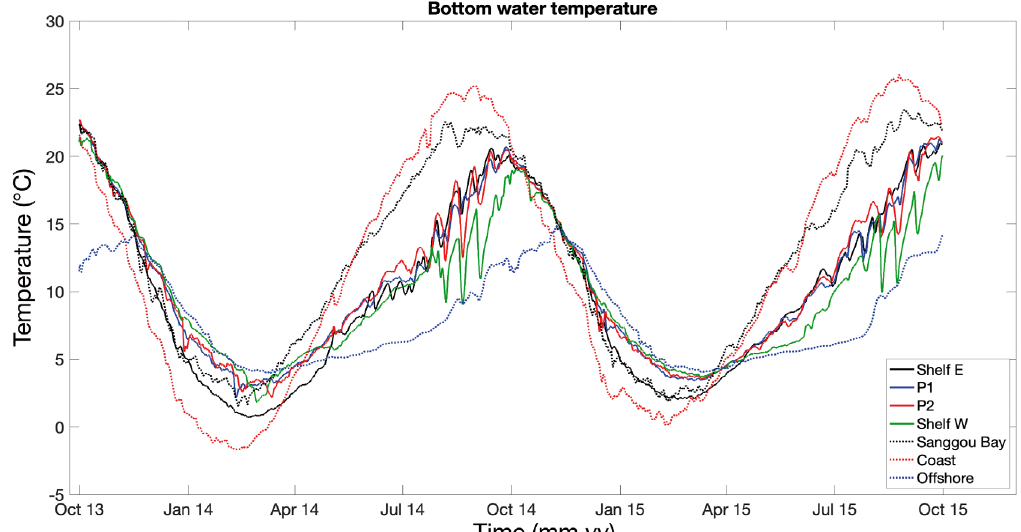
Fig. 4. Time series of bottom water temperature from locations at the northern shelf of the Yellow Sea and at Sanggou Bay. The positions are marked on the map in Fig. 1, and the line colors are similar to the colors of the dots. Black dotted line: Sanggou Bay location; red dotted line: location near the coast; blue dotted line: location offshore in the